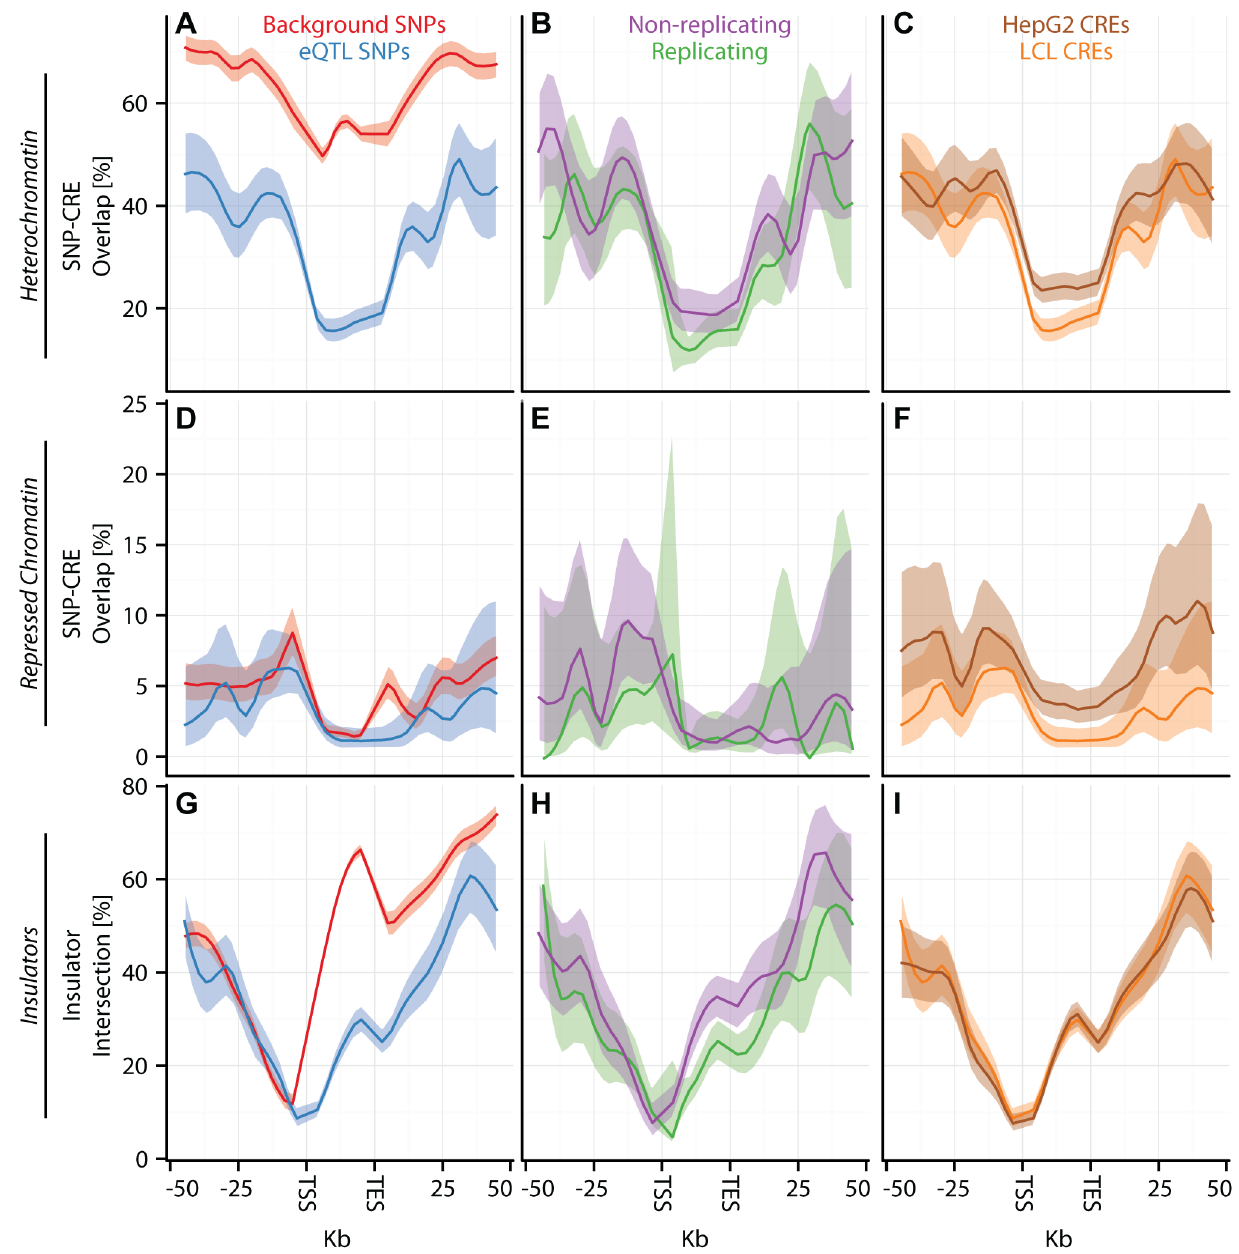
Figure 4. eQTL SNPs are depleted within repressive chromatin contexts. (A–I) CAP_LCL eQTL SNP ( FDR ƒ 5% ) overlap with predicted cis- regulatory elements. (A–C) eQTL SNP overlap with chromHMM predicted heterochromatin, (D–F) eQTL SNP overlap with chromHMM predicted repressive chromatin, (G–I) eQTL SNP-TSS pairs with an intervening CTCF binding site. In each panel, SNPs are grouped into 25 equally spaced bins within the 50 kb upstream and downstream of the TSS and TES, and 10 bins between the TSS and TES. Each bin is plotted along the x-axis. Bold lines depict bin percentage, ribbons depict 95% confidence interval. Each column of panels depicts a distinct SNP set contrast. (A,D,G) Observed eQTL SNPs (blue) and randomly drawn cis-linked SNPs at expressed genes(red). (B,E,H) eQTL SNPs that replicate in Stranger_LCL ( log 10 BF § 1 ) (green) and SNPs that fail to replicate (purple). (C,F,I) CAP_LCL eQTL SNP overlap with CREs derived from the LCL line GM12878 (orange) and HepG2 cells (brown).